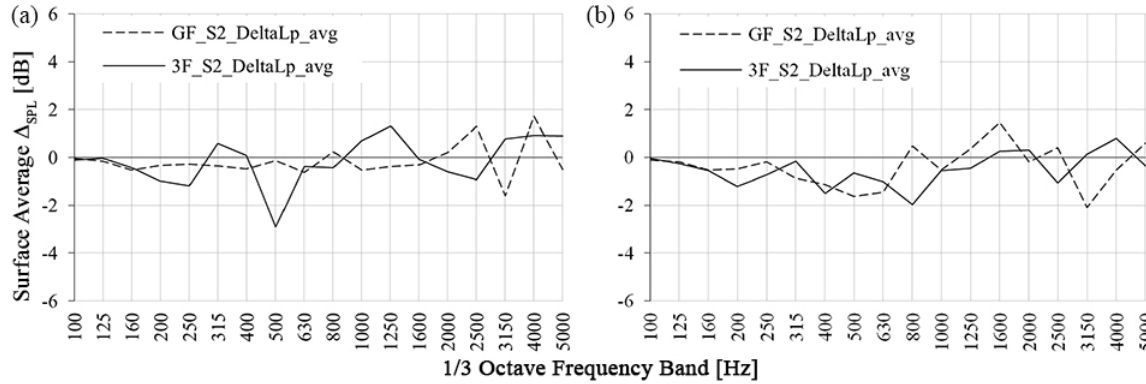
Figure 9. Δ SPL calculated between SPL on the glass surfaces of windows averaged over all the microphone positions. Ground floor (dashed line) and third floor (solid line). Source position in S2 , as it is in Figure 4. ( a ) Δ SPL = A SPL − B1 SPL ; ( b ) Δ SPL = A SPL − B2 SPL . Configurations A, B1, B2 are as they are in Figure